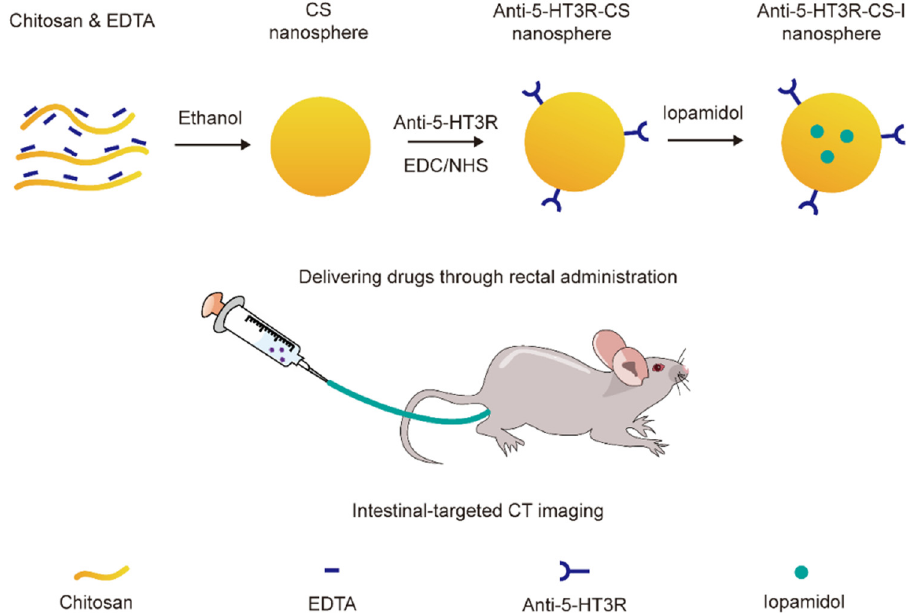
Figure 1: Schematic illustration of the formation of AH - CS - I Ns preparation and its application in intestinal - targeted CT